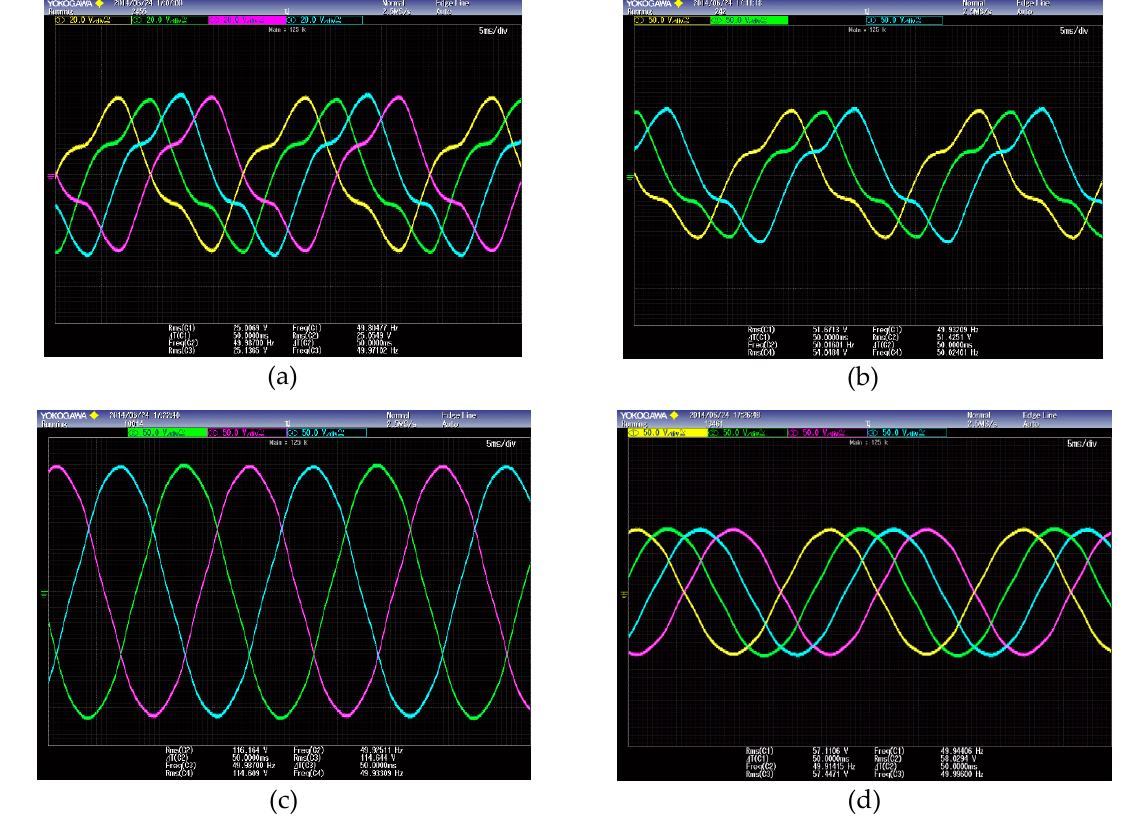
Figure 16. ( a ) Symmetrical six-phase output with star-connected primary; ( b ) quasi six-phase output with primary in star; ( c ) symmetrical six-phase output with Delta-connected primary; ( d ) quasi six-phase output with delta-connected primary.